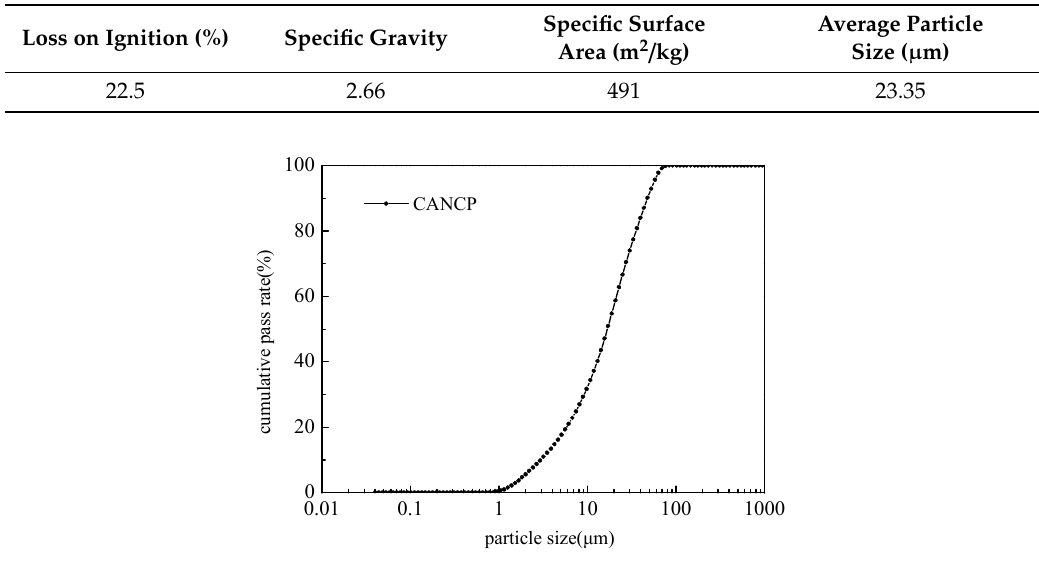
Figure 1. Particle size distribution curves of CANCP.